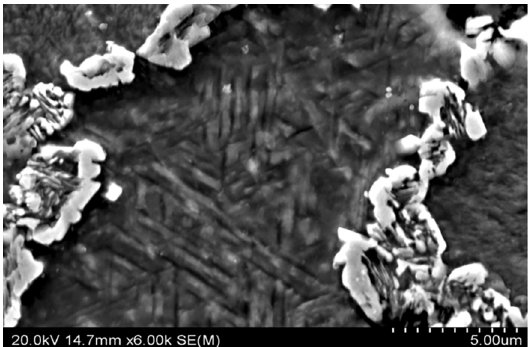
Figure 8. High magnification SEM image of sintered samples processed under condition 4 showing the fine structure with needle- like contrast attributed to martensitic